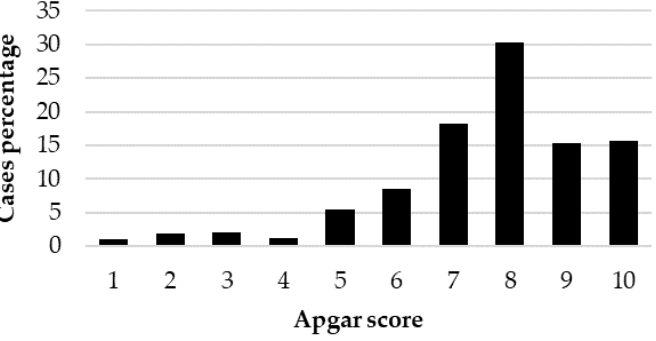
Figure 1. Distribution of the Apgar score (case percentage) in the 1039 live-born puppies. The distribution of the 1039 live-born puppies in the viability classes (case percent- age) is reported in Table 5. Table 5. Distribution (expressed as number and %) of the 1039 live-born puppies in the viability classes.